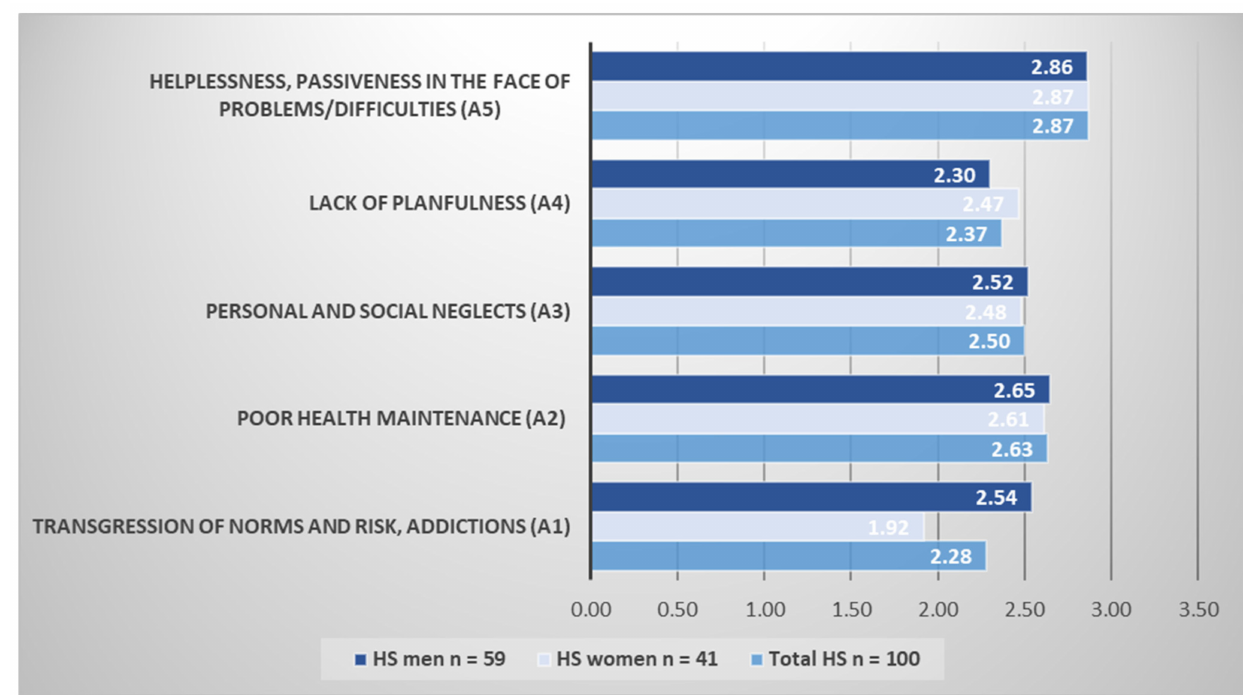
Figure 1. The average point value for a question in individual classes of indirect self-destructiveness in HS